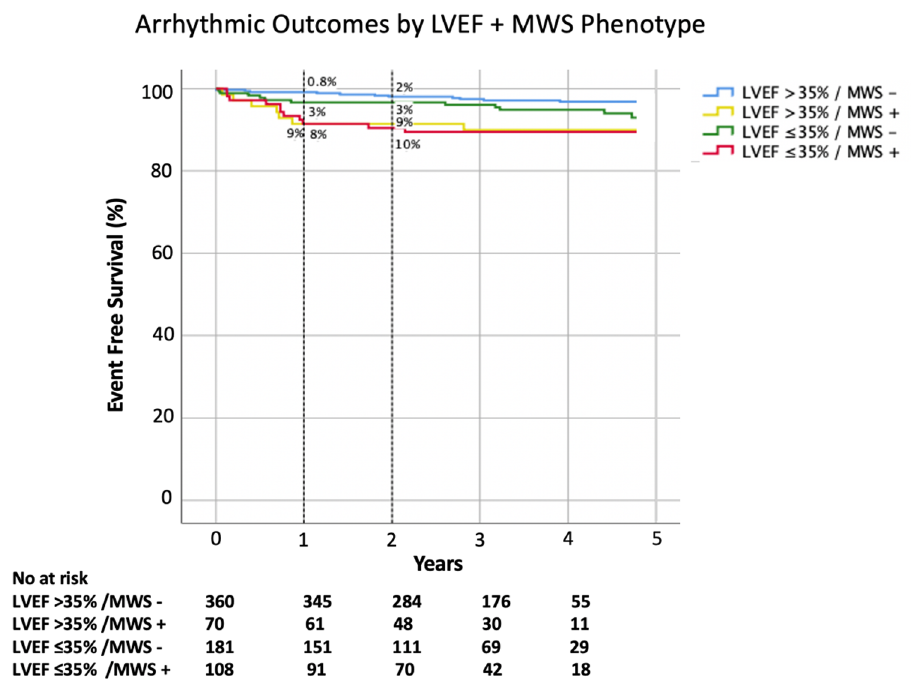
Figure 8. Kaplan–Meier event free survival curve for the secondary arrhythmic outcome of appropriate ICD therapy, sudden cardiac death (SCD), survived sudden cardiac arrest (SCA), or sustained VT requiring cardioversion stratified by the combined presence or absence of mid-wall striae (MWS) fibrosis and LVEF ≤